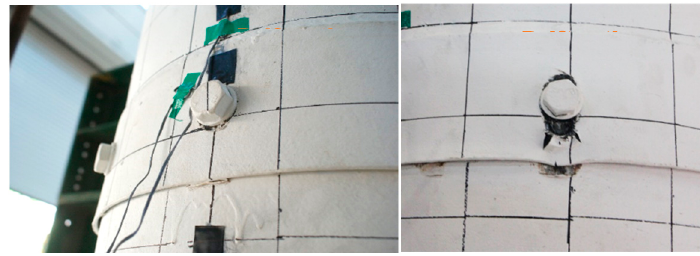
Figure 25. Failure of connecting plate of SP-S.